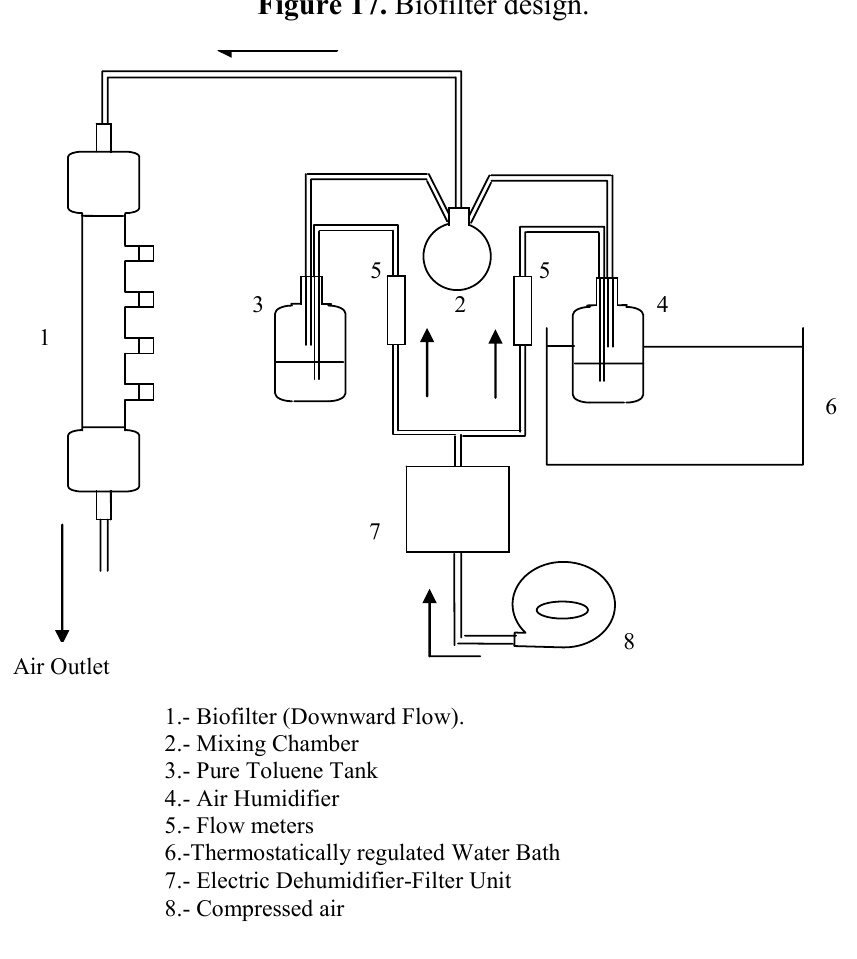
Figure 17. Biofilter